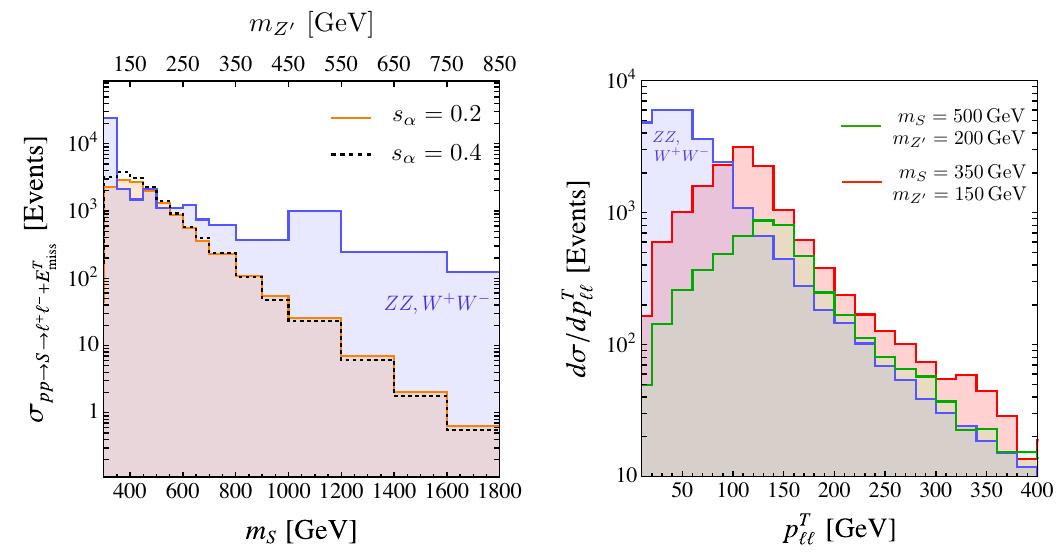
Figure 12: Left: signal and background events for pp → S → µ + µ − + / E s α = 0.2 and 0.4, after all cuts. Right: signal and background rates for two bench- mark